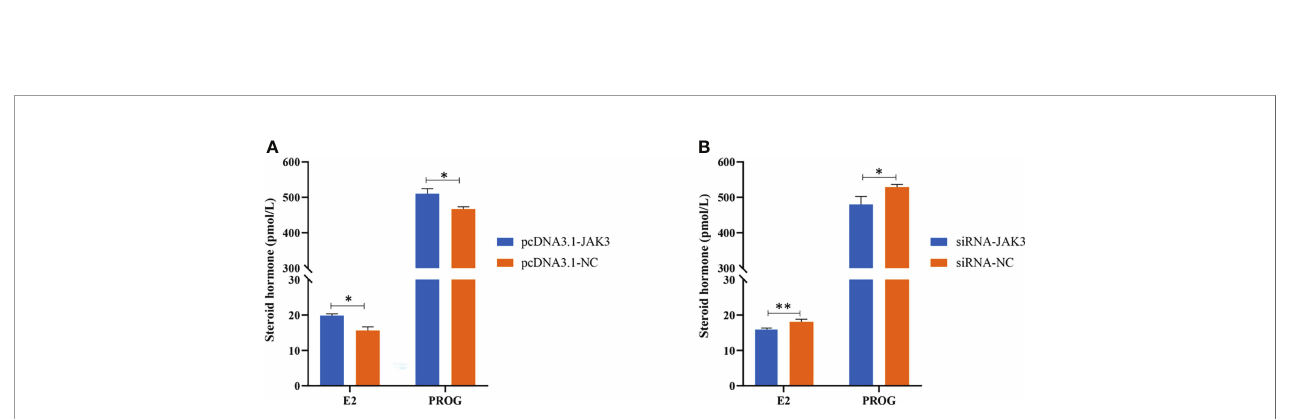
FIGURE 7 | JAK3 promotes steroid hormone synthesis. Goat granulosa cells are transfected with pcDNA3.1-JAK3 or pcDNA3.1-NC (A) , and siRNA-JAK3 or siRNA-NC (B) . After 24h, cell-free supernatants are collected and estrogen (E 2 ) and progesterone (PROG) secretions are measured in 50- m l supernatants using ELISA kits. Values are expressed as mean±SD of n =3. * p <0.05, ** p